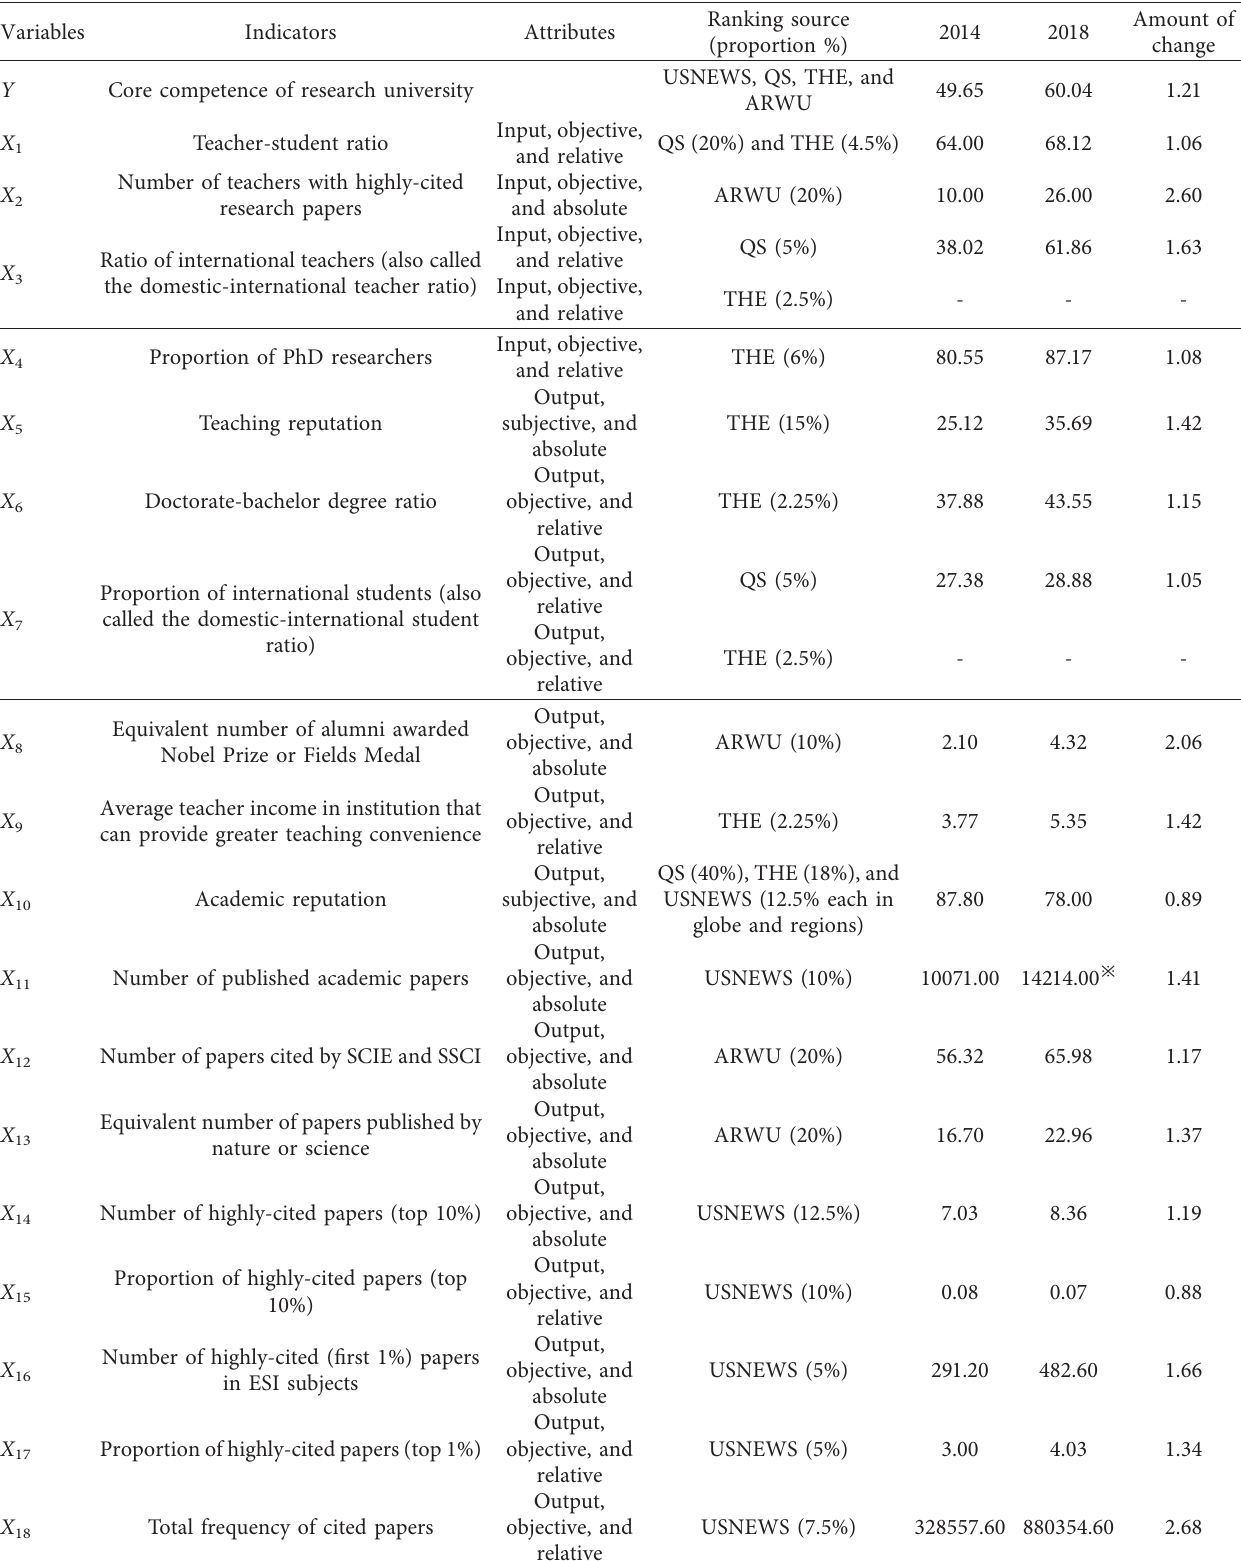
Table 1: Description of the influencing indicators of the core competence of Chinese research universities